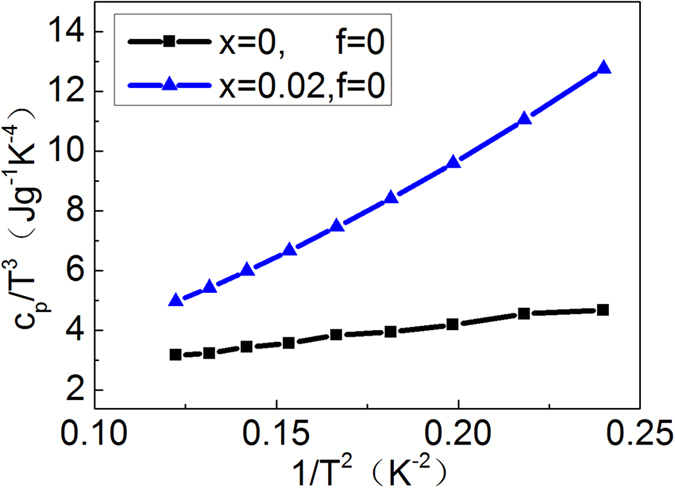
Cp/T3 vs 1/T2 plots of Zn4Sb3 (α phase) and Pb0.02Zn3.98Sb3 (α phase).